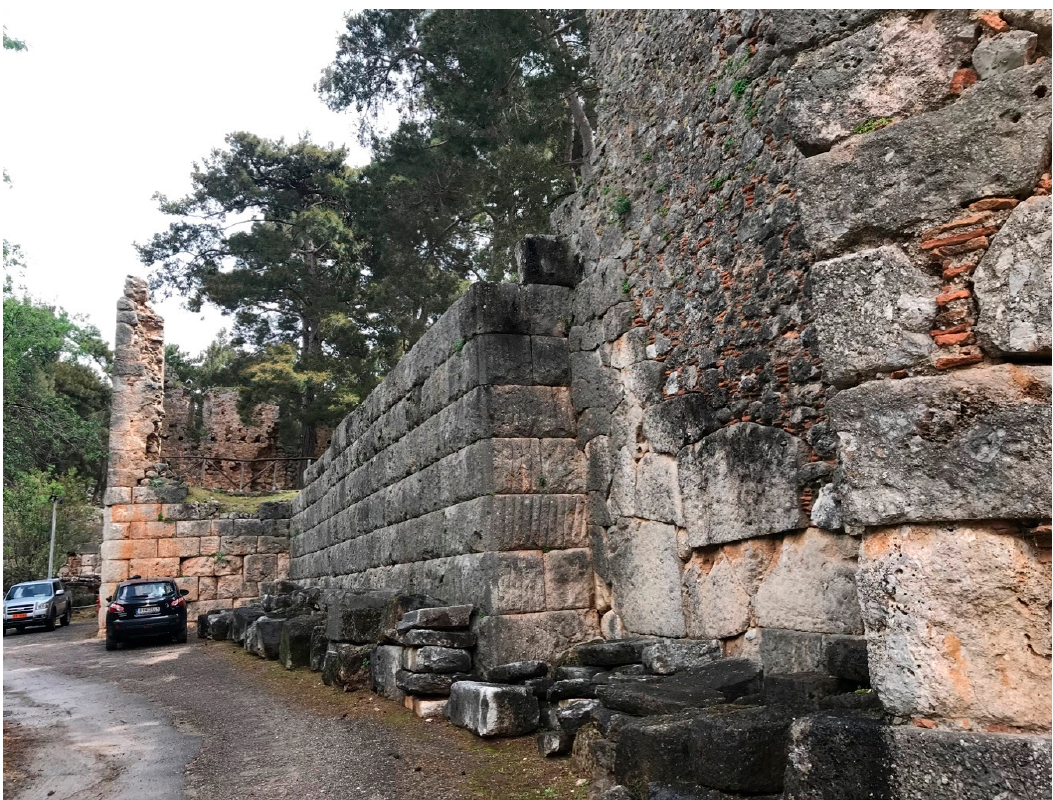
Figure 3. Combined decay: seismic effects, salt weathering, vegetation growth, and different construction phases over centuries. Apparent exfoliation and detachment of the outermost layers of the stone. The Castle of Amfissa, Greece, March 2019.